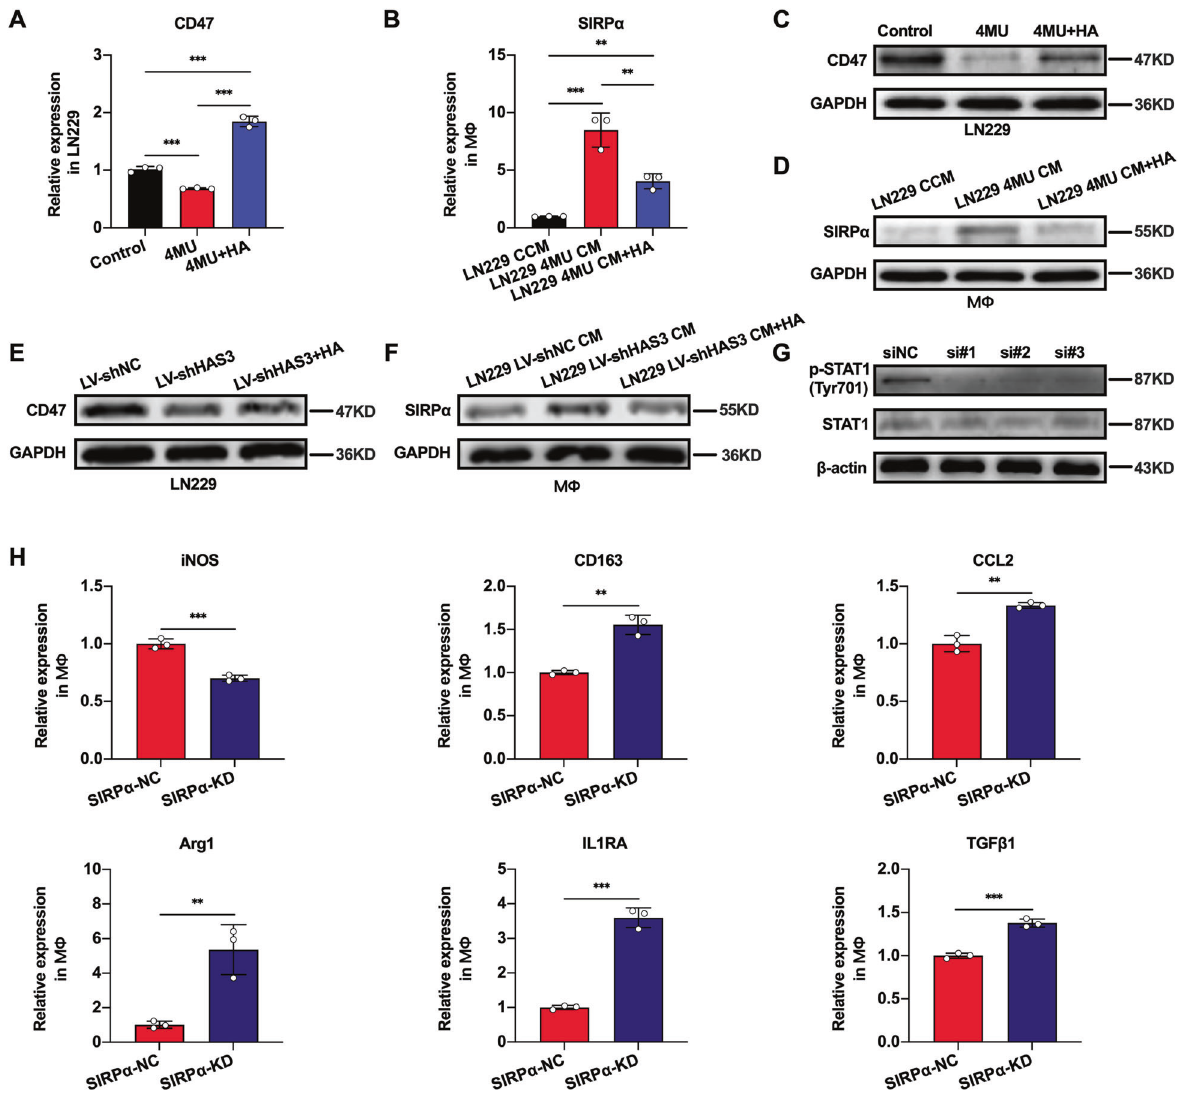
examined by qRT-PCR and Western blotting, respectively. B , D Macrophages were cultured with 4MU CM for 48 h, and one of the treatment groups was extra treated with exogenous HA (25 μ g/ml). The relative expression levels of SIRP α mRNA and protein in macrophages were determined by qRT-PCR and Western blotting, respectively. E The relative levels of CD47 protein in LN229 glioblastoma cells stably transfected with HAS3 knockdown lentivirus, followed by cultured with HA (25 μ g/ml) for 48 h. F Macrophages were cultured with LV-shHAS3 CM for 48 h, and one of the treatment groups was extra-treated with exogenous HA (25 μ g/ml). The relative protein levels of SIRP α in macrophages were examined by Western blotting. G The relative protein levels of p-STAT1, STAT1 in macrophages with SIRP α knockdown were determined by Western blotting. H The relative mRNA expression levels of iNOS, CD163, CCL2, Arg1, IL1RA, and TGF β 1 were detected by qRT-PCR, after SIRP α was knocked down in macrophages. Error bars show mean ± SD. * P < 0.05, ** P < 0.01, and *** P <